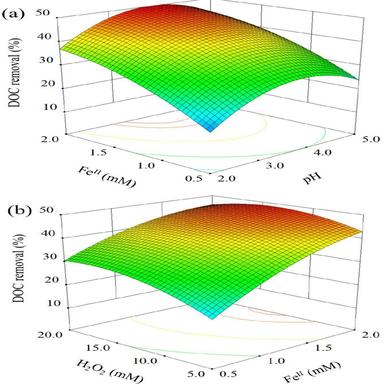
Mineralization efficiencies of EfOM in the IPWTP secondary effluents by Fenton oxidation process upon (a) initial pH and FeII dosages (with 10 mM H2O2 and 3.0 h RT); and (b) H2O2 and FeII dosages (with initial pH 3.0 and 3.0 h RT).